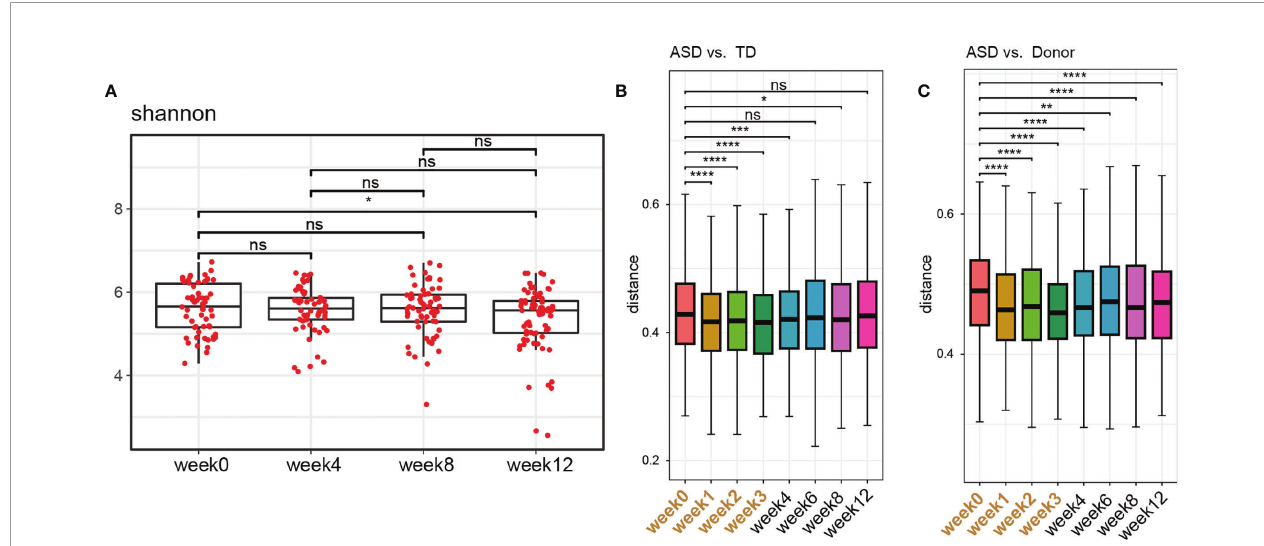
FIGURE 4 | Gut microbiota changes after FMT. (A) Changes in alpha diversity were determined using Shannon indices in stool samples from children with ASD collected at different time points. The two-tailed Wilcoxon signed-rank test was used to analyze the difference. *P < 0.05. ns, not signi fi cant. (B) Unweighted UniFrac distance between ASD children treated with FMT at each timepoint and TD controls. (C) Unweighted UniFrac distance between ASD children treated with FMT at each timepoint and donors. The two-tailed Wilcoxon signed-rank test was used to analyze the difference. *P < 0.05, **P < 0.01, ***P < 0.0001. ****P < 0.00001. NS, not signi fi